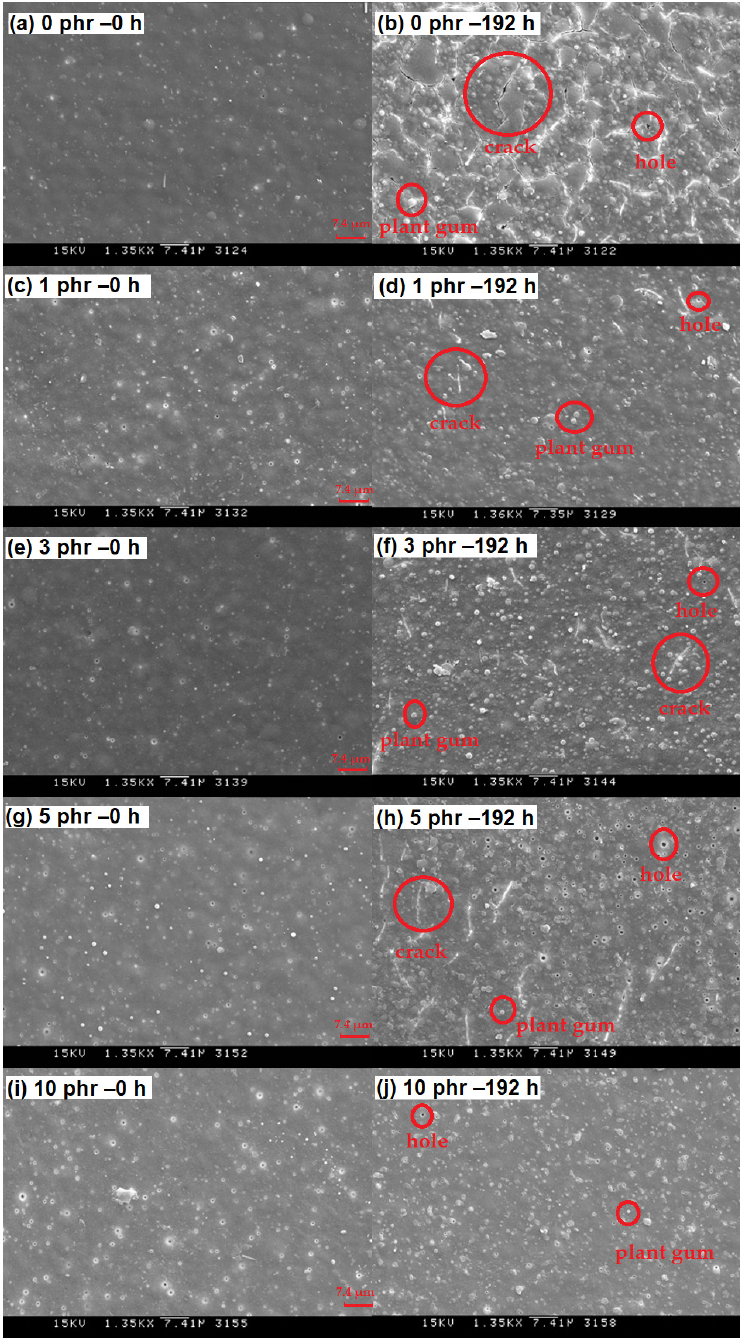
Figure 5. Scanning electron microscopic analysis (1350×) of ROL films with various A. confusa heartwood extractive additions in the irradiation test. ( a ) 0 phr – 0 hr; ( b ) 0 phr – 192 hr; ( c ) 1 phr – 0 hr;